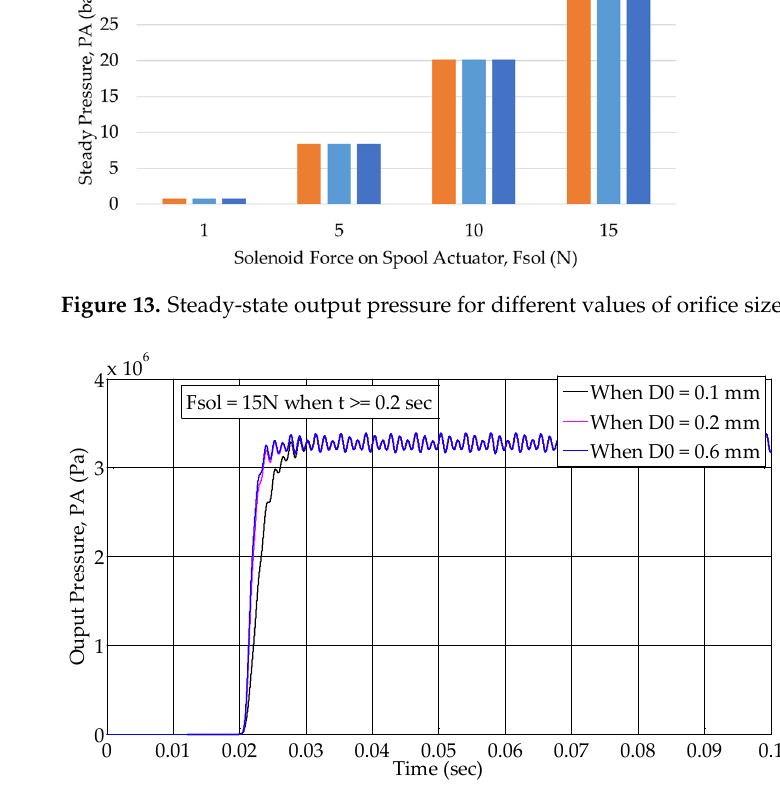
Figure 14. Transient response of output pressure for different values of orifice size.